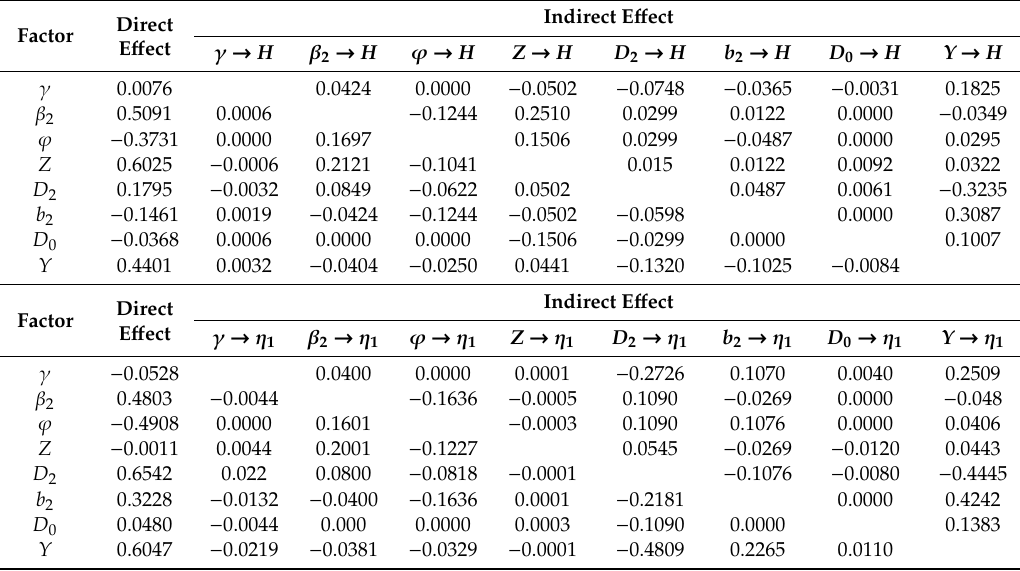
Table 2. Path analysis results between impeller geometric parameters and